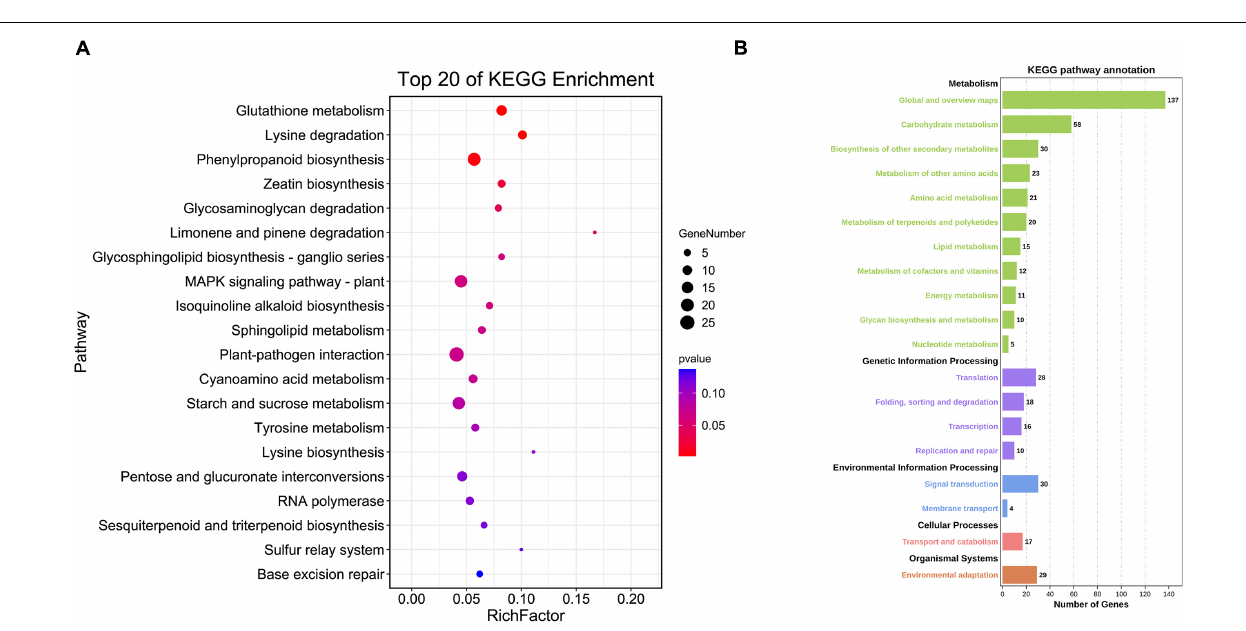
FIGURE 7 | Gene Ontology (GO) analysis of WRKY target genes in Boehmeria nivea . Categories pertaining to cellular components, molecular functions, and biological processes were defined by GO classification.